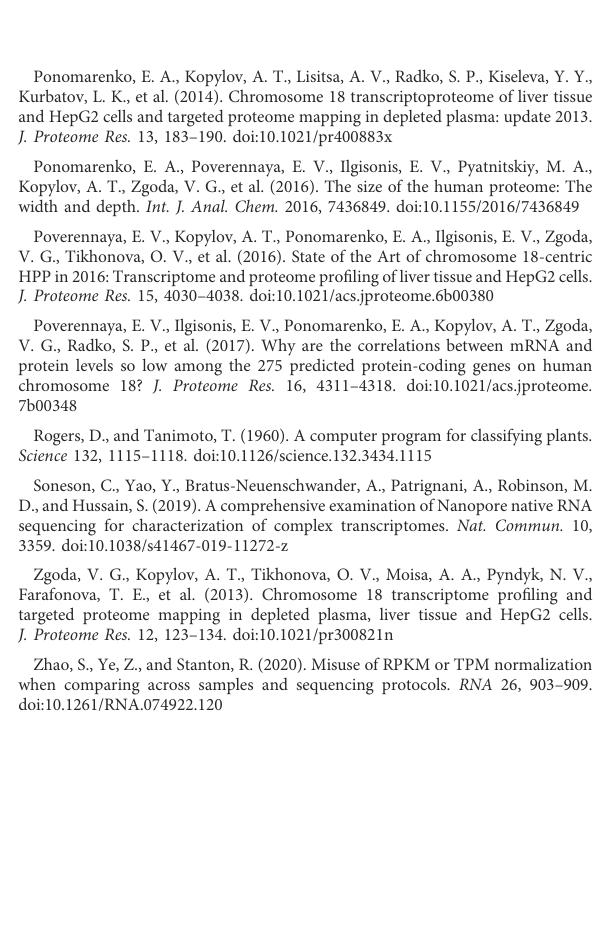
SUPPLEMENTARY MATERIAL S2 Initial data: excel table — by donors and average